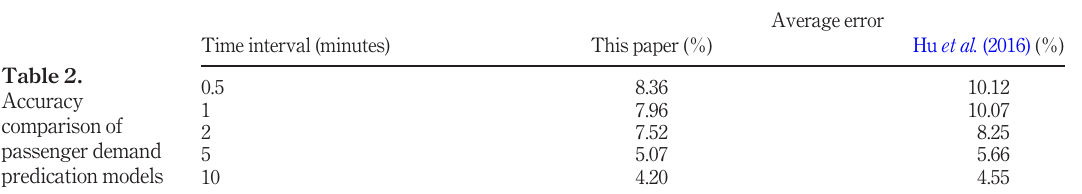
Figure 4. Calculated passenger demand at Beijing West Metro Station